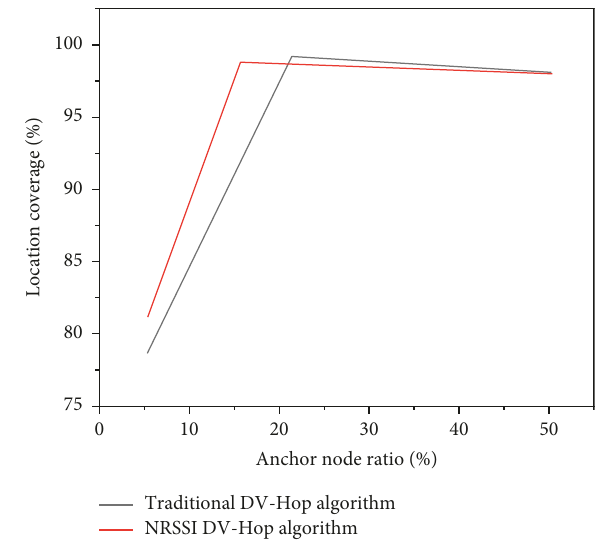
Figure 12: Comparison of location coverage.